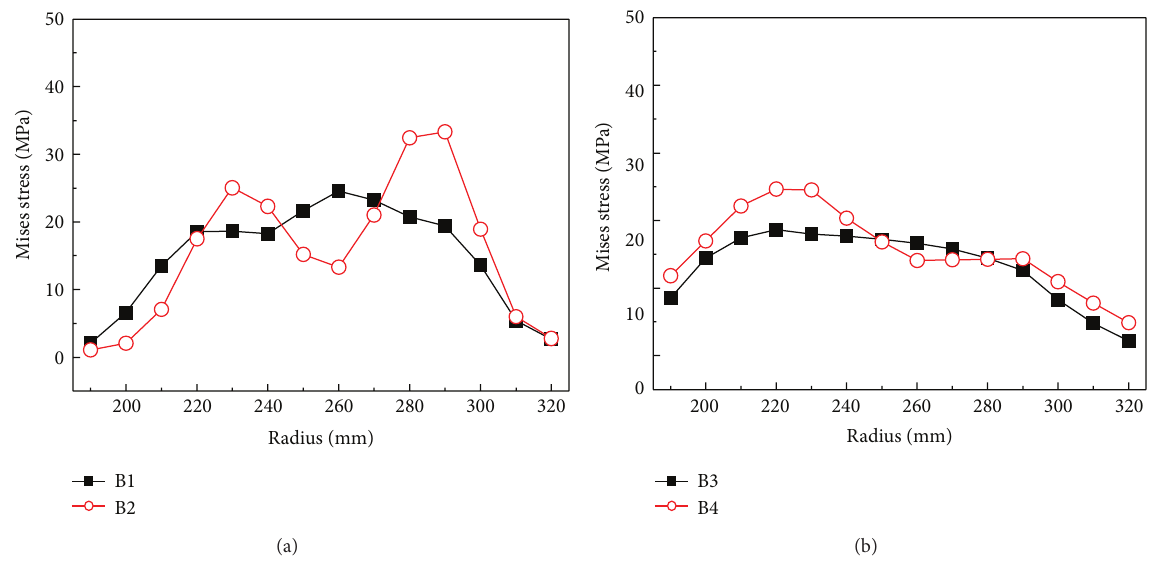
Figure 14: Relationship between thermal pressure and friction